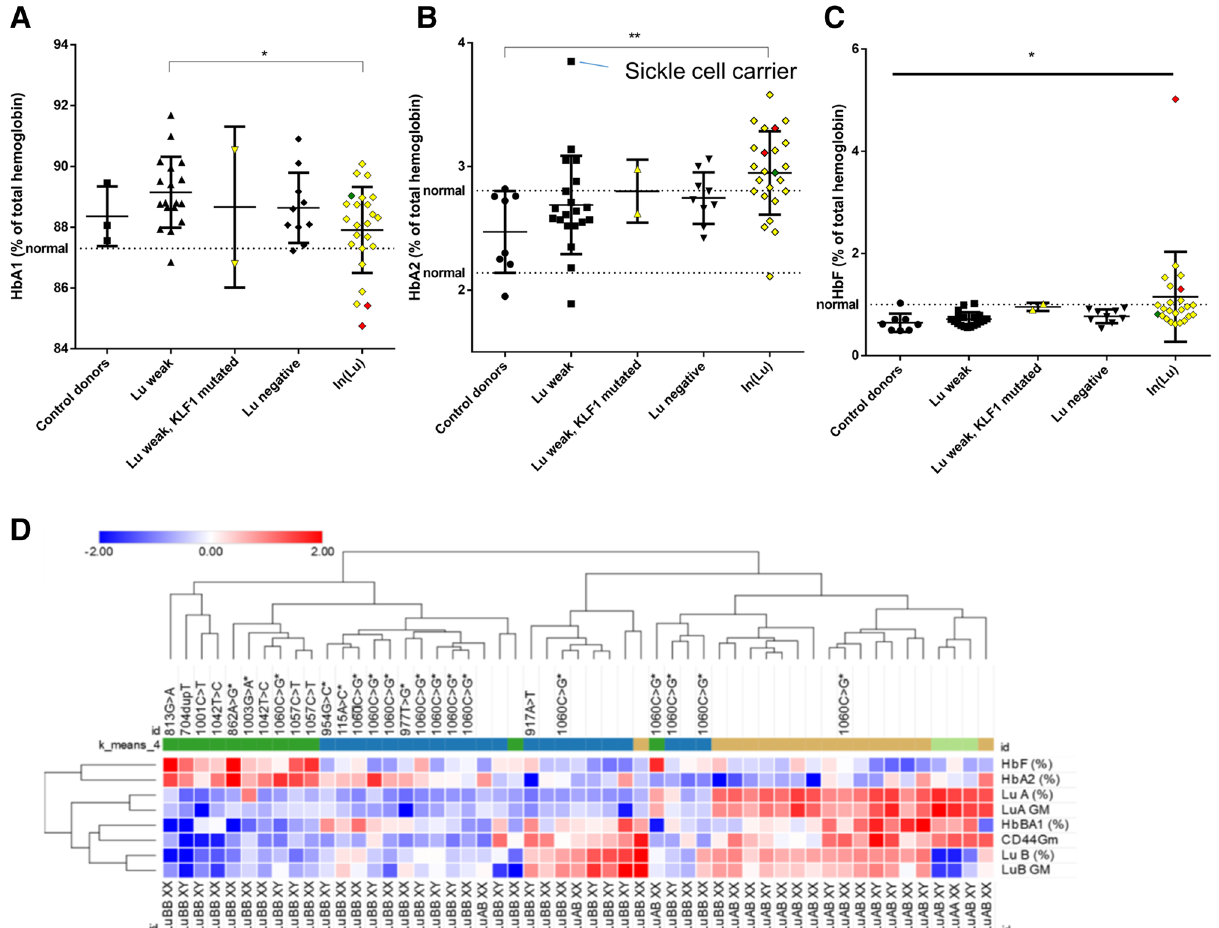
Figure 4. Donors that have KFL1 variants show an elevated Fetal Hemoglobin (HbF) and alpha 2 hemoglobin (HBA2) expression. Expression of HBA1 (A) , HBA2 (B) , HbF (C) was plotted against specific groups as indicated. The “normal” dotted base-line indicates the average of all control individuals. Donors were divided in groups based on their Lu expression and the presence of KFL1 variants. The graph shows the average hemoglobin expression per individual measured 3 times (* indicates P value of < 0.1; *** indicates a P value of < 0.001; Tukey’s multiple comparisons test was used for A and B, for C an unpaired student T-test on In(Lu) vs control donors groups was performed. E ). The heatmap displays a hierarchical Euclidean complete clustering of columns and rows ( GM geometric mean fluorescence) using Morpheus software. Lower part indicates the MLPA genotyping and upper part shows the various variants found within KLF1. K-means clustering was performed using 10,000 interactions and N = 4 clusters. Note that this clustering segregates the KLF1 variants that correlate with increased HbF from the rest of the samples (clustered to the left side of the pared to untreated or scrambled shRNA control cultures (Supplementary Fig. 8A–D), which confirmed the crucial role of KLF1 during erythropoiesis. Expression of mutant KLF1 in primary human erythroblasts recapitulates the HPFH pheno- type. Next we evaluated if expression of KLF1 variants interfered with hemoglobin subunit expression and/ or resulted in elevated HbF expression. HBG1/2 and HBB1 protein levels were measured on different time points of EBL differentiation using FCM (Fig. 6A). Expression of a scrambled shRNA did not lead to increased HBG1/2 expression in erythroblasts. However, erythroblasts transduced with shRNA against KLF1 show a significant increase of HBG1/2 expression during differentiation indicating the prominent role of KLF1 in repressing gamma globin expression (Fig. 6B). Re-expression of wild type KLF1 led to a reduction HBG1/2. Erythroblasts expressing the c.1042 T > C, c.813G > C and c.704dupT variants have higher averages of HBG1/2 when com- pared to EBL treated with scrambled RNA or wild KLF1. Only c.704dupT variant demonstrated significantly higher HBG1/2 levels. These data indicate that specific expression of KLF1 mutants in primary erythroblasts can cause HPFH.